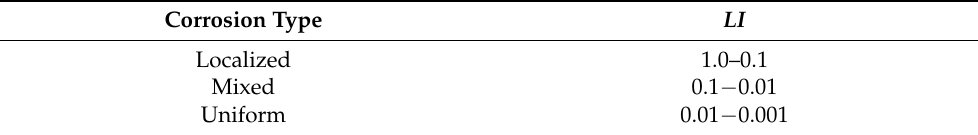
Table 3. The type of corrosion process depends on the localization index ( LI